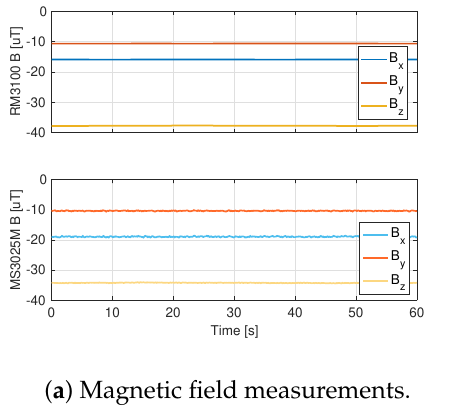
( b ) Error measurements.